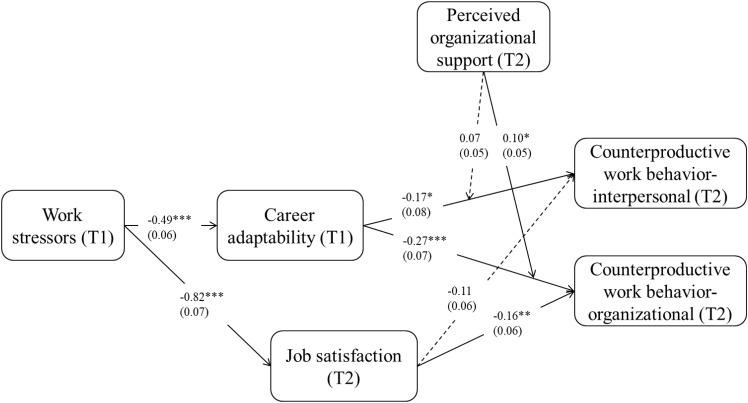
The final model with unstandardized coefficients. ∗p < 0.05, ∗∗p < 0.01, ∗∗∗p < 0.001.